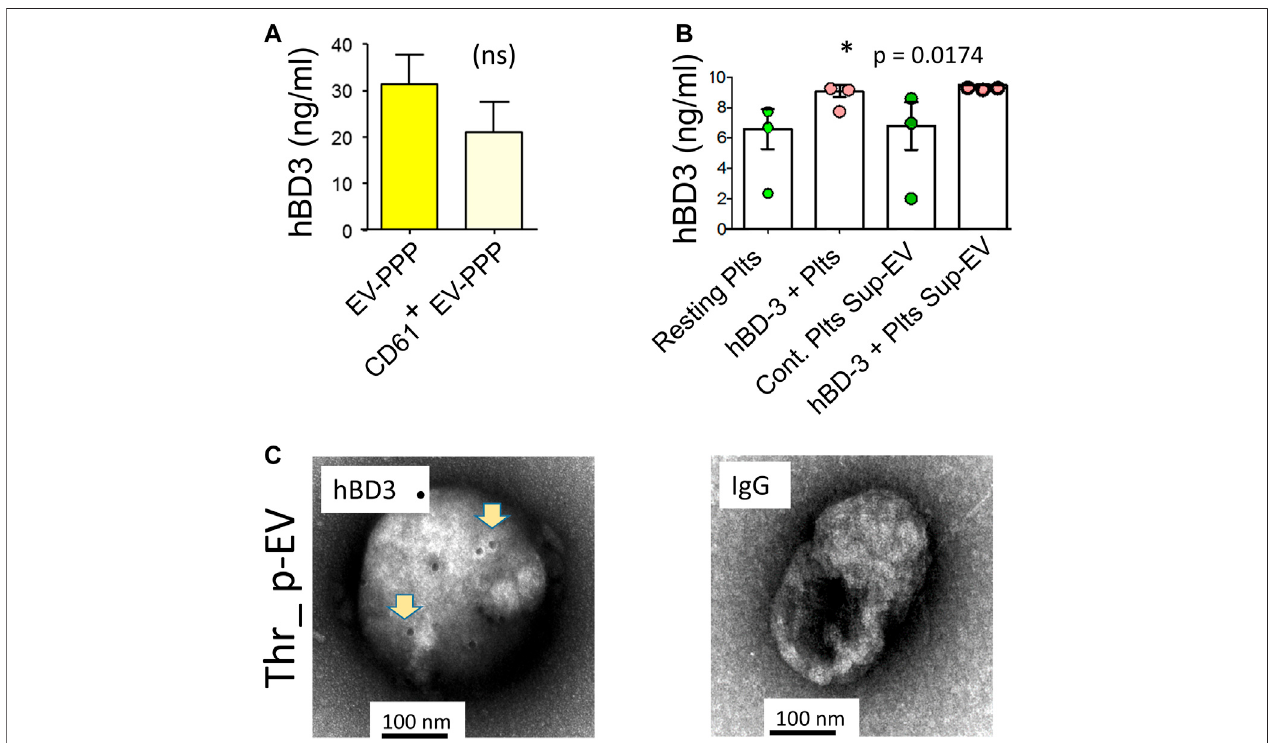
FIGURE 3 | Detection of hBD-3 in platelet-derived EVs (p-EVs). (A) ELISA data from three identical experiments showing hBD-3 concentrations on EVs from platelet poor plasma (EV-PPP), and CD61 + EV-PPP (platelet speci fi c EVs puri fi ed from PPP, volume normalized). (B) ELISA data from three identical experiments indicating the presence of hBD-3 in lysates from resting and hBD-3 (100 nM) pre-incubated platelets (hBD3-Plts), and in EVs puri fi ed from the supernatant of resting (Resting Plts Sup-EV) and hBD-3 exposed platelets (hBD-3 Plts Sup-EV), (* p = < 0.05). (C) Representative negative-EM image of hBD-3 on immuno-gold-stained p-EVs, puri fi ed from thrombin activated platelet supernatant (left panel), and respective isotype control (right